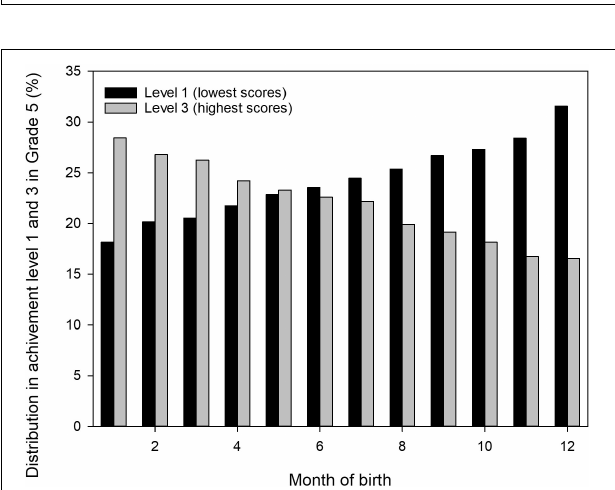
FIGURE 2 | Percentage distribution of Grade 5 pupils in achievement level 1 (lowest scores) and achievement level 2 (highest scores) for each month of